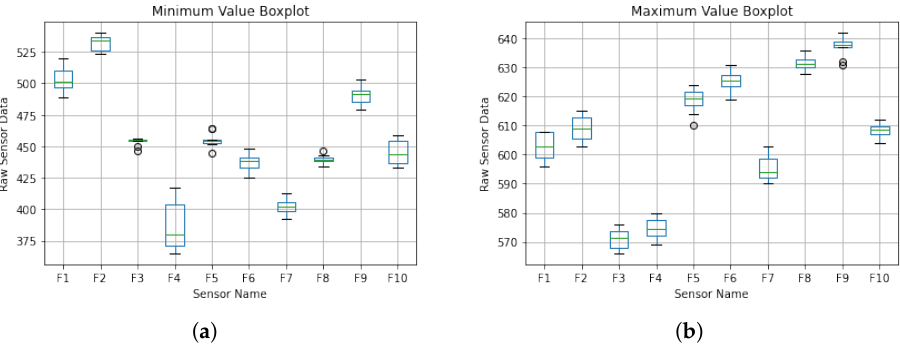
Figure 4. Box and whisker plot of sensor readings for the calibration of the bending. ( a ) Minimum Value, occurs during maximum bend, ( b ) Maximum Value, occurs during initial Pose.